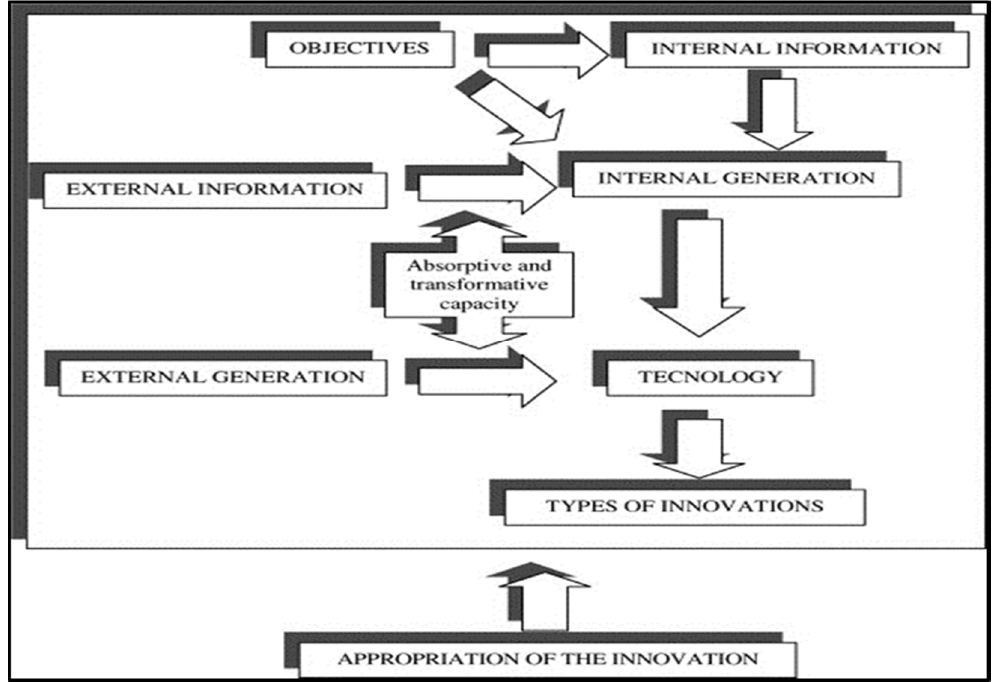
Figure 1: An Explanatory Model Of The Innovative Proces Firms aim to gain competitive advantages against their competitors by innovating. The table-1 shows the factors relating to the objectives and effects of innovation types. Product and marketing innovations are mainly interested in competition, demand and markets, process and organisational innovations mainly interested in production and delivery and also workplace